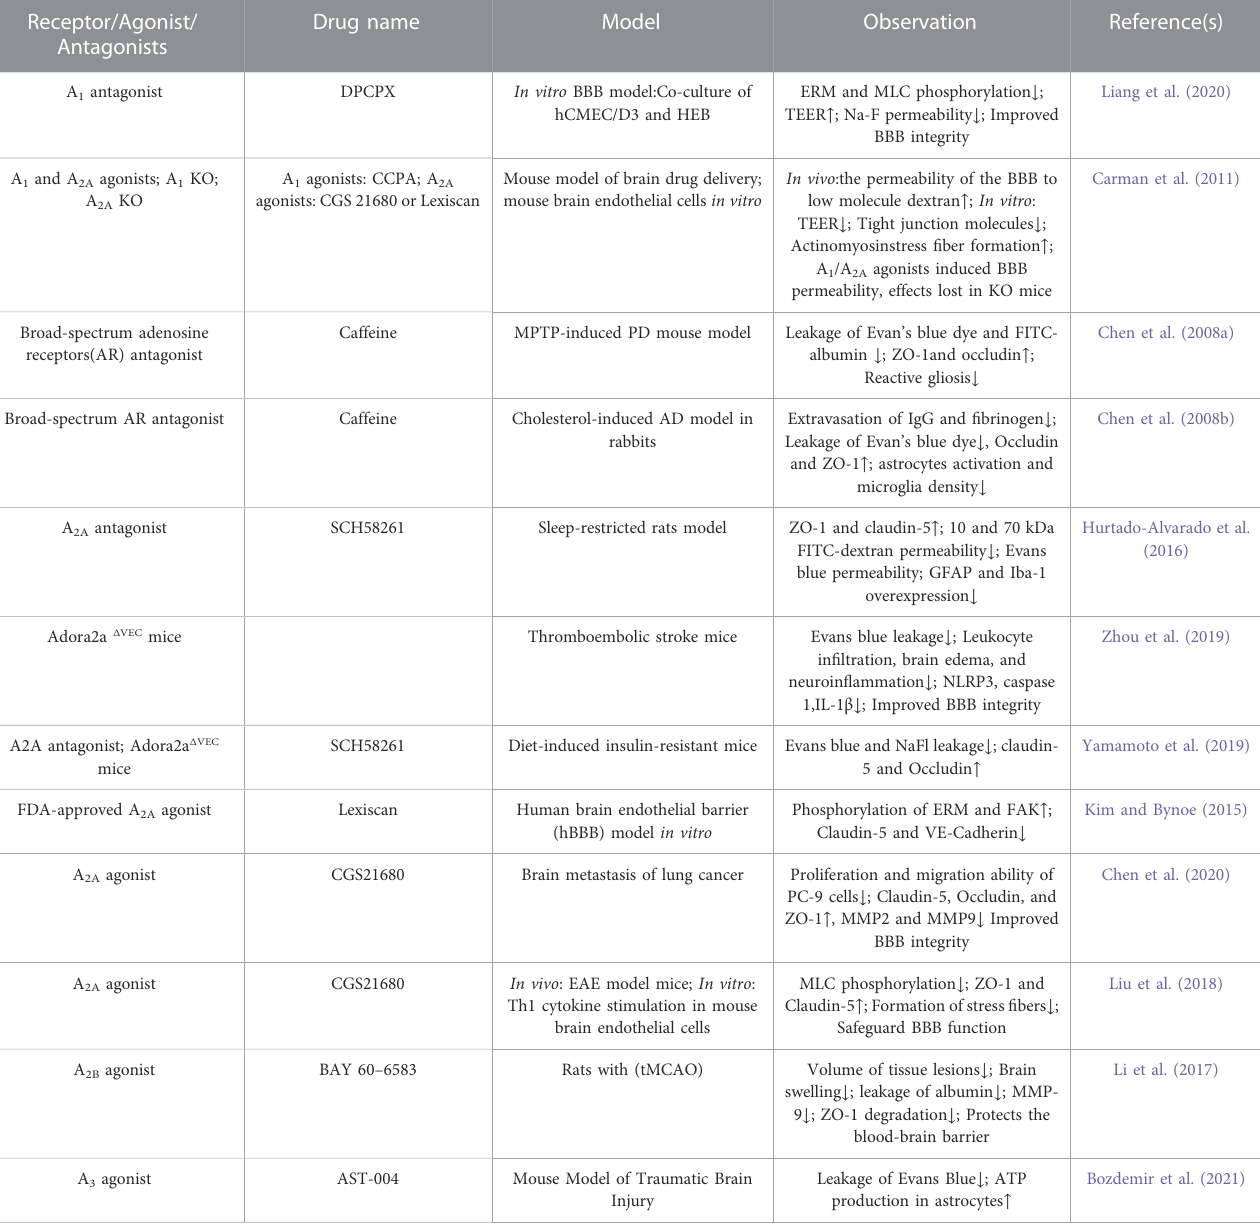
TABLE 2 Effect of P1 receptors agonist/antagonist on blood-brain barrier